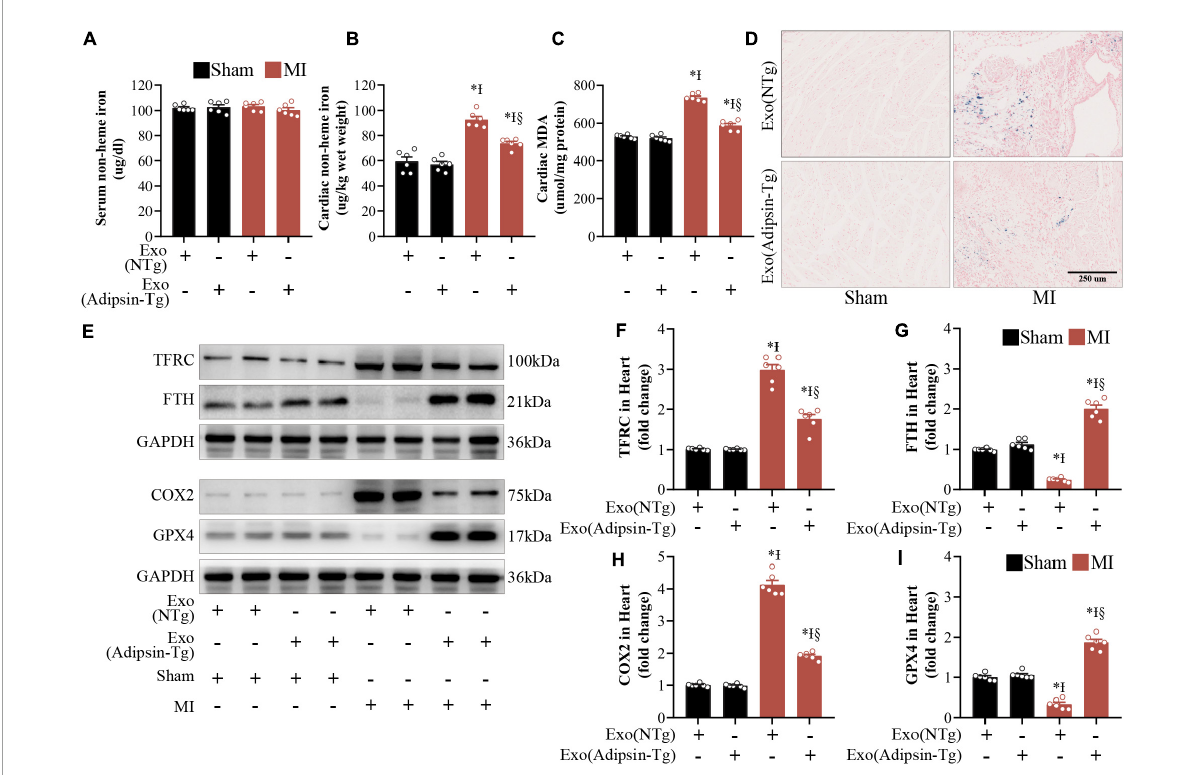
FIGURE5 Adipsin-enriched pericardial-AT exosomes regulate iron homeostasis and alleviate lipid oxidative stress in vivo . (A,B) Non-heme iron levels in the serum and the peri-infarct region of the cardiac tissue were assessed in MI mouse after treatment with Adipsin-transgenic or non-transgenic exosomes. Each group n = 6, * p < 0.05 vs. Sham + Pericardial-AT exosomes from Adipsin-NTg mice, I p < 0.05 vs. Sham + Pericardial-AT exosomes from Adipsin-Tg mice, § p < 0.05 vs. MI + Pericardial-AT exosomes from Adipsin-NTg mice. Data were mean ± SEM, and one-way ANOVA was used for statistical analysis. (C) The levels of malondialdehyde (MDA) in cardiac tissue were measured in the peri-infarct area. Each group n = 6, * p < 0.05 vs. Sham + Pericardial-AT exosomes from Adipsin-NTg mice, I p < 0.05 vs. Sham + Pericardial-AT exosomes from Adipsin-Tg mice, § p < 0.05 vs. MI + Pericardial-AT exosomes from Adipsin-NTg mice. Data were mean ± SEM, and one-way ANOVA was used for statistical analysis. (D) Perls’ Prussian Blue-stained heart slices. (E–I) TFRC, FTH, COX2, and GPX4 proteins were measured by Western blots. Each group n = 6, * p < 0.05 vs. Sham + Pericardial-AT exosomes from Adipsin-NTg, I p < 0.05 vs. Sham + Pericardial-AT exosomes from Adipsin-Tg, § p < 0.05 vs. MI + Pericardial-AT exosomes from Adipsin-NTg. Data were mean ± SEM, and one-way ANOVA was used for statistical